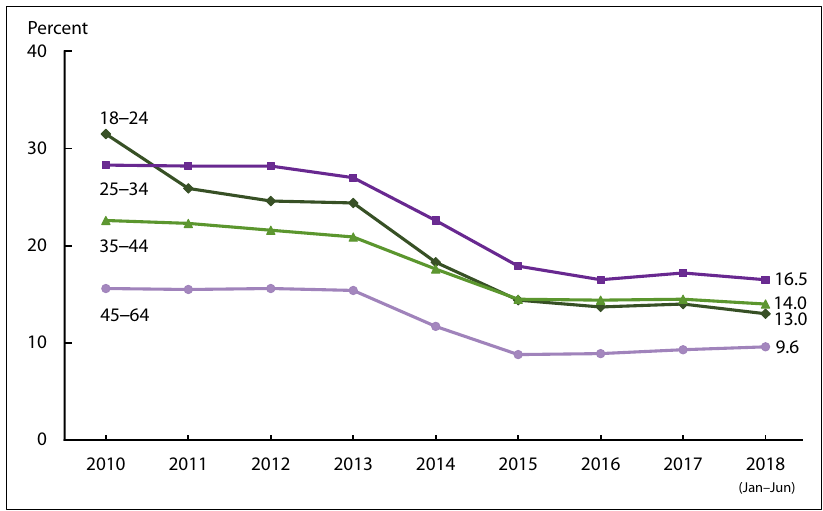
Figure 3. Percentage of adults aged 18–64 who were uninsured at the time of interview, by age group: United States, 2010–June